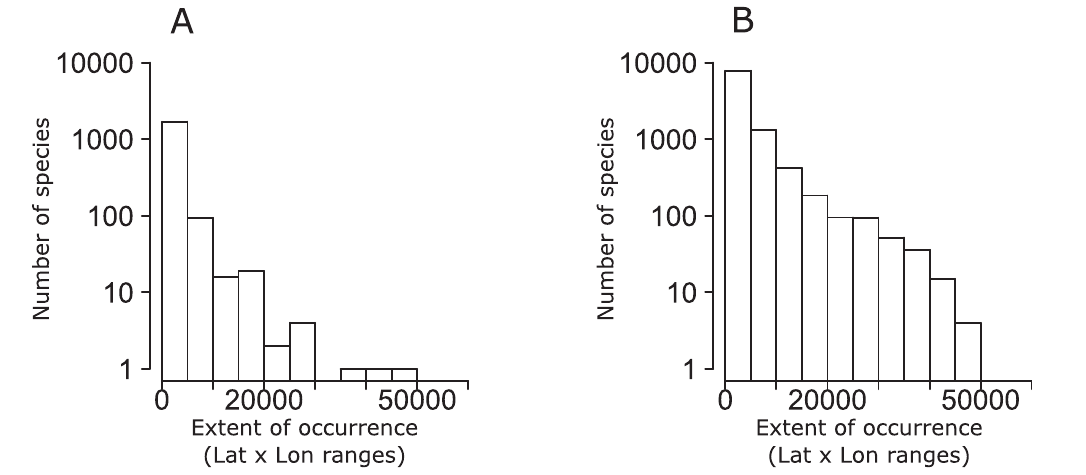
Figure 2. Frequency distribution plots of geographic range sizes expressed as extent of occurrence (EOO, number of grid cells of 1 6 along the maximum latitudinal range 6 number of grid cells of 1 6 along the maximum longitudinal range of each species) in freshwater (A) and marine (B) fishes.